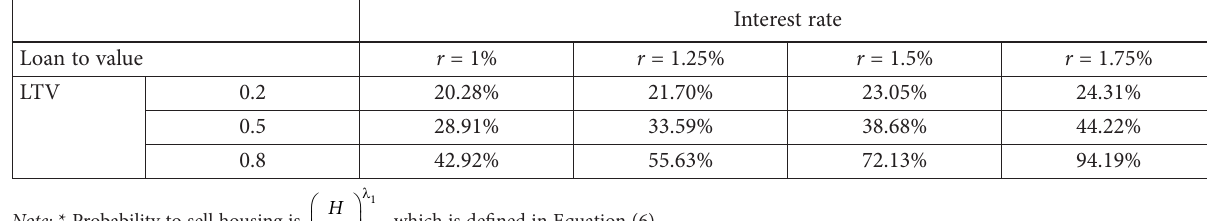
Table 5. Probability for homeowners to sell houses across LTV ratio and interest rate *